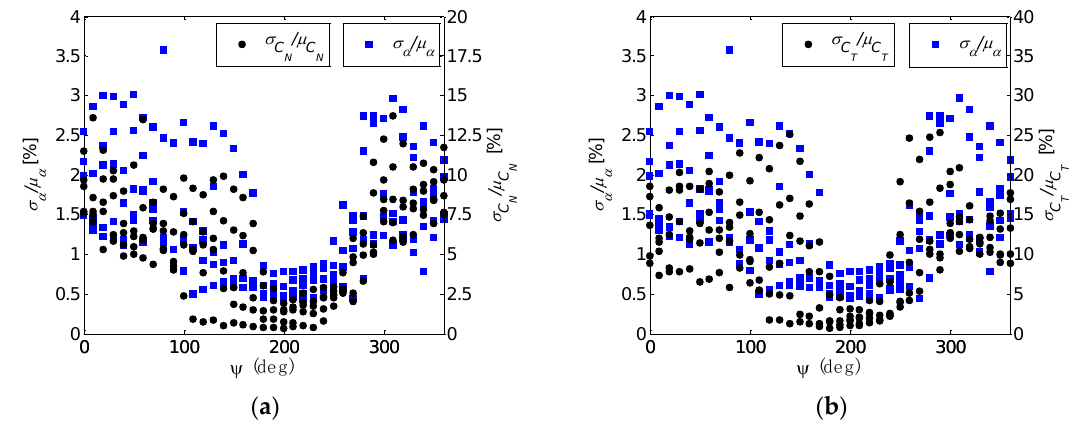
Figure 10. Variation of the normalized standard deviations in ( a ) angle of attack α and normal force coefficient C N , and ( b ) angle of attack α and tangential force coefficient C T with blade azimuth angle for r { R = 30%, 46%, 63%, 80%, and 95%, U = 15 m/s, and Ψ = 30 ˝